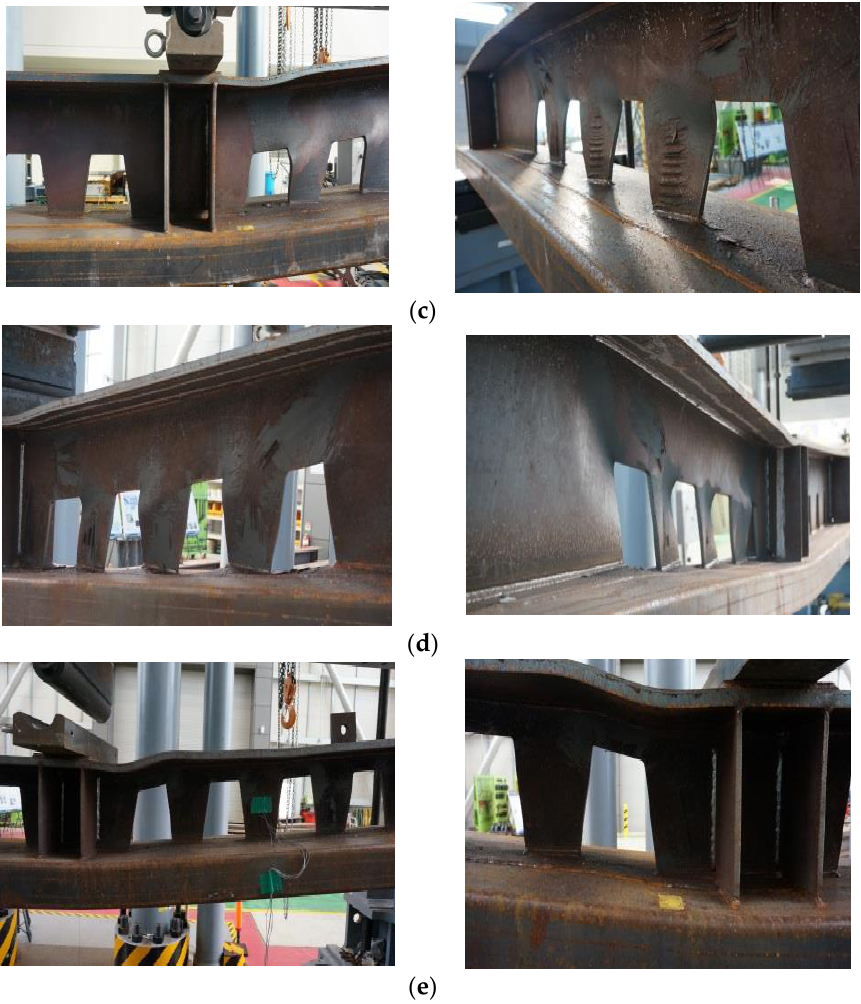
Figure 13. Ultimate failure modes of the non-composite specimens: ( a ) 588-WF-X; ( b ) 505-TF-X-R1; ( c ) 505-TF-O-R1; ( d ) 505-TF-O-R2; ( e ) 390-TF-O-R1.